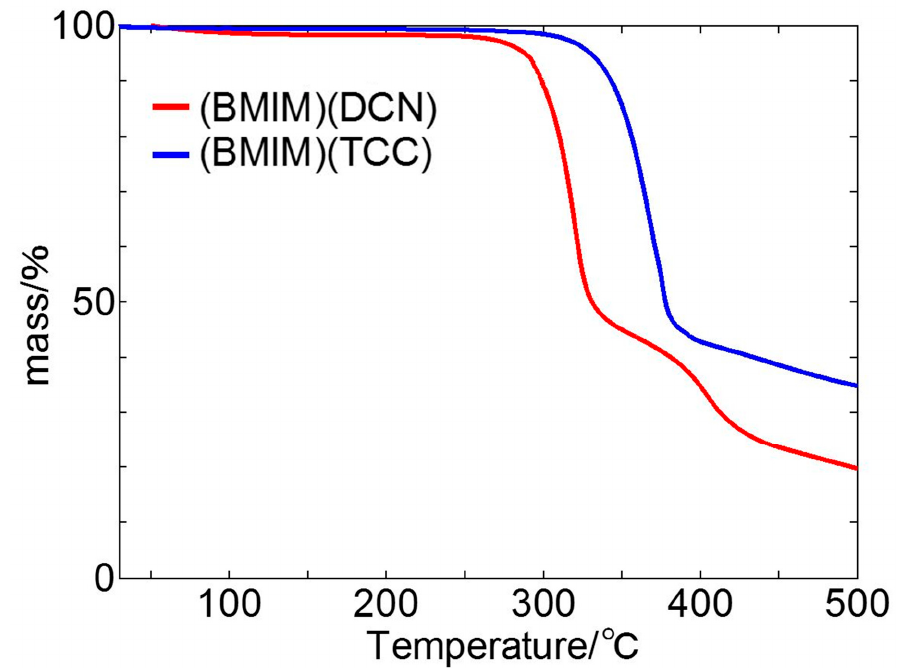
Figure 9. Thermal stability of (BMIM)(DCN) and (BMIM)(TCC).